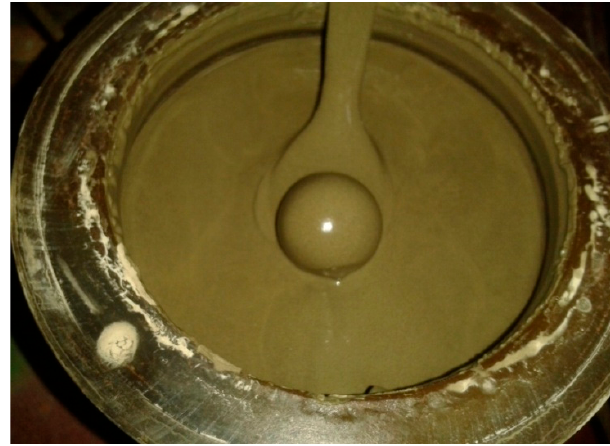
Figure 3. Inside view of wet-grinding of cement.